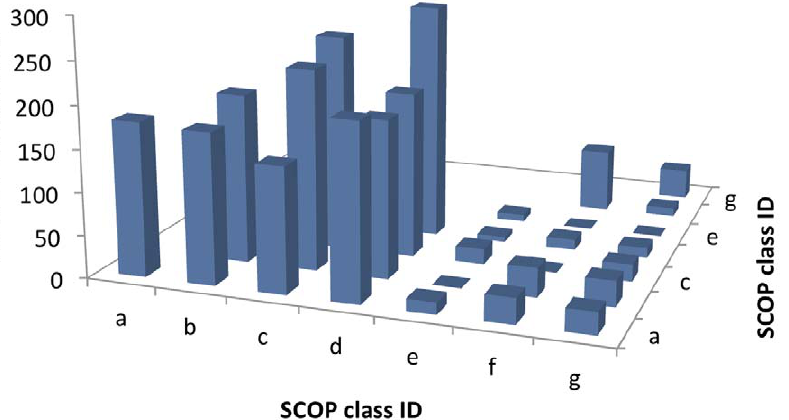
Figure 5. Distribution of SCOP class ID pairs from the training dataset of protein-protein interactions. The dataset covers all SCOP class IDs, while the uneven distribution of the pairs is consistent with the unevenness in the overall distribution of protein structures across the SCOP classes.